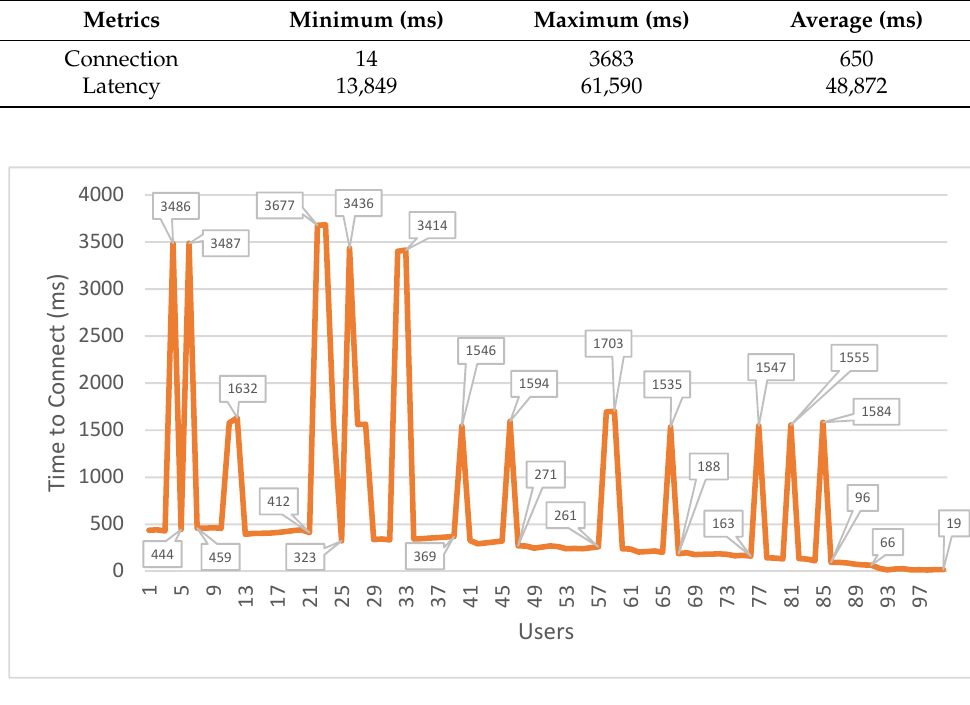
Figure 5. Connection time versus number of users.